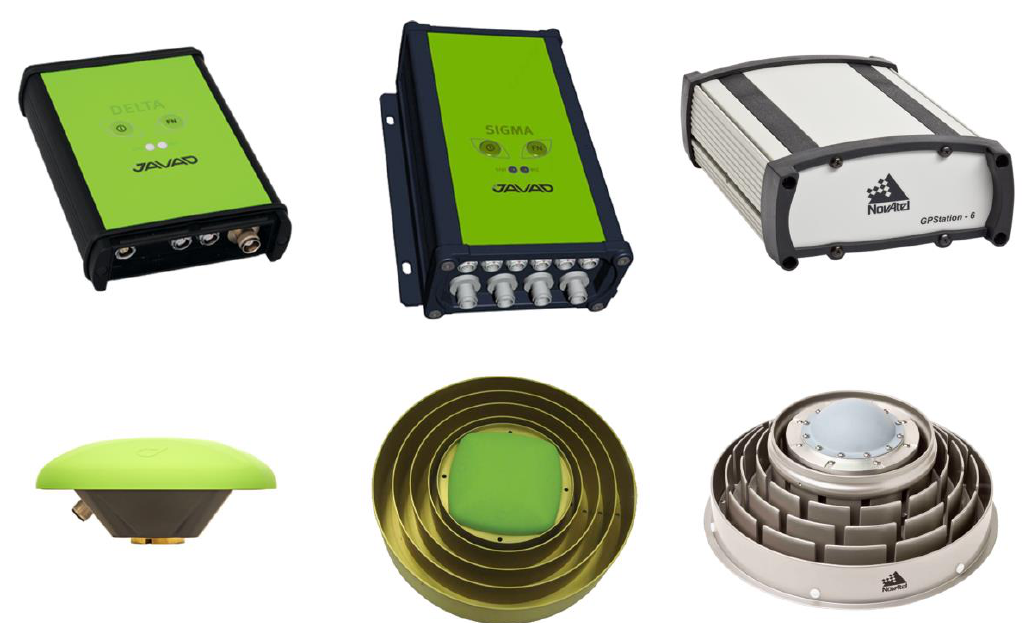
Figure 2. Equipment used in the SibNet . Top: JAVAD Delta , JAVAD SigmaQ , NovAtel GPStation-6 GNSS receivers. Bottom: GrAnt-G3T , RingAnt-G3T , NovAtel GNSS-750 GNSS antennas.